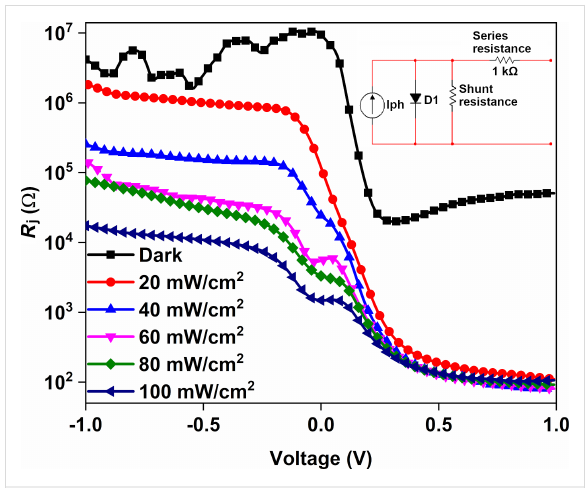
Figure 6: R j – V plots (with equivalent circuit of serial and shunt resis- tance in the inset) of the Au/CuNiCoS 4 /p-Si photodiode for different illumination power